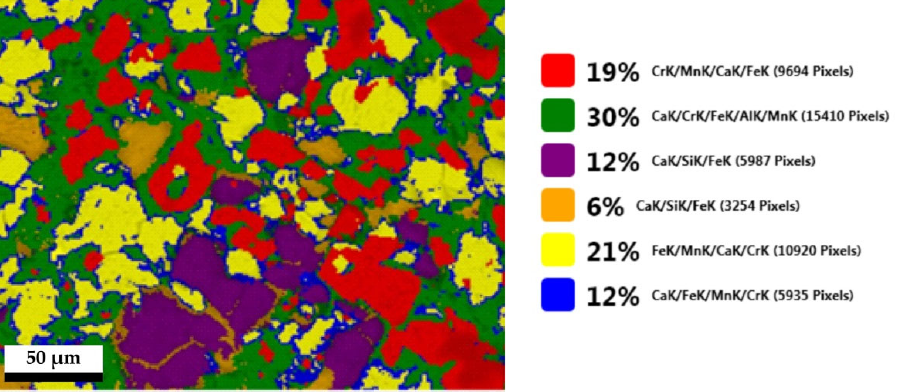
Figure 8. Distribution of phases, recalculated from EDS mapping from scanning electron microscopy of the elements Al, Si, Ca, Cr, Mn, Fe, and O in EAF slag.